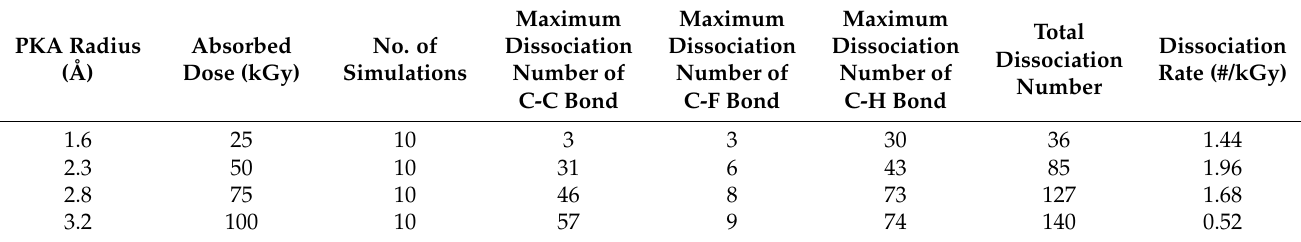
Table 2. Maximum dissociation number of each bond in 1F-PS (poly(4-fluorostyrene)) @ 1 ps.